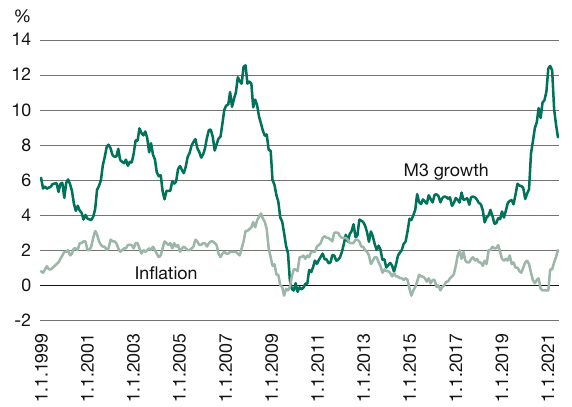
Figure 1 Infl ation and M3 growth rate in the eurozone